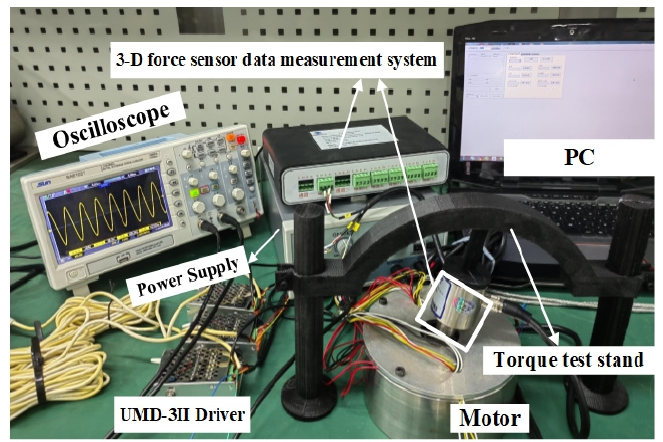
Figure 15. Torque test platform.